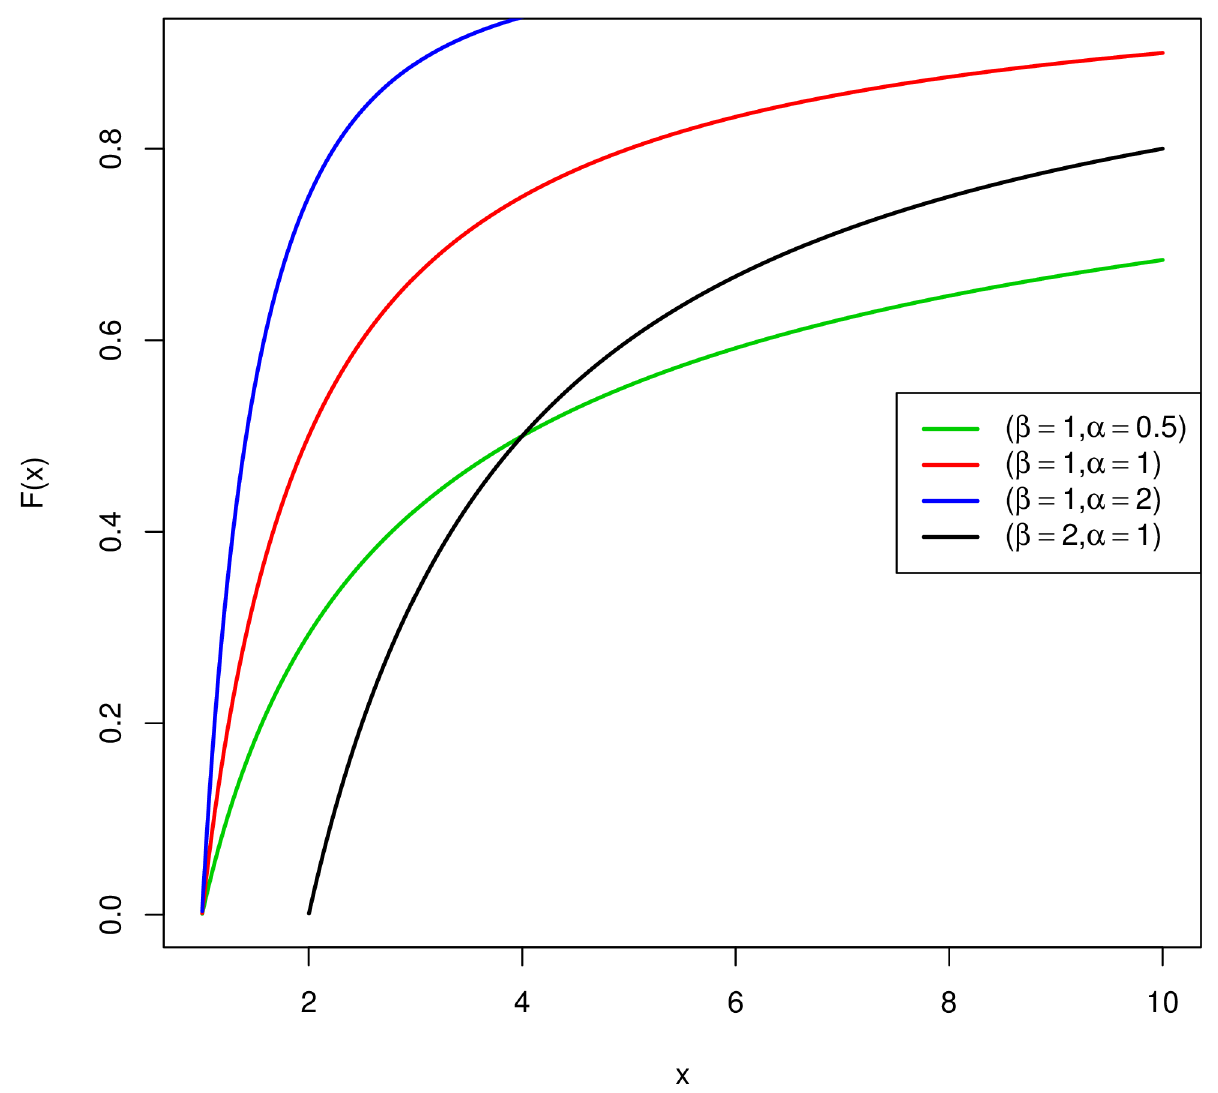
Fig 2. CDF of the Pareto